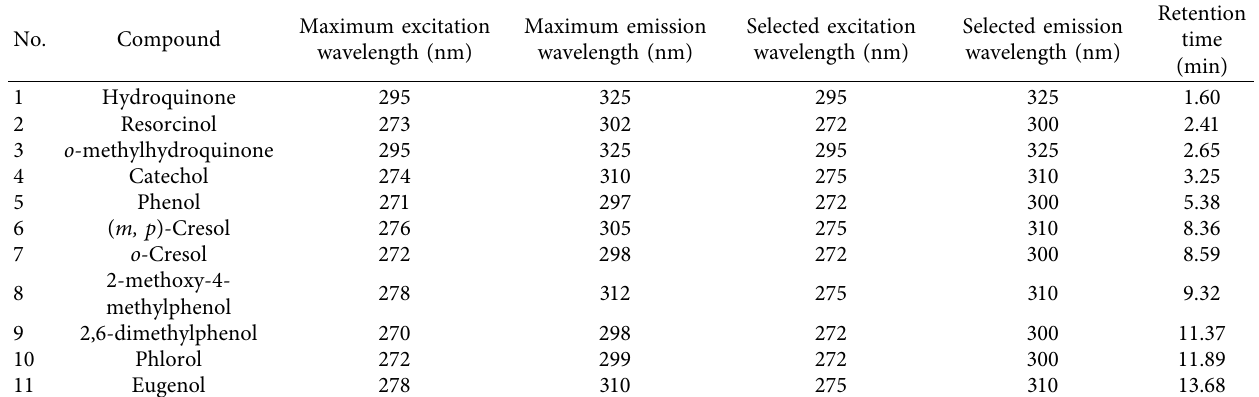
Table 1: Wavelengths for fluorescence